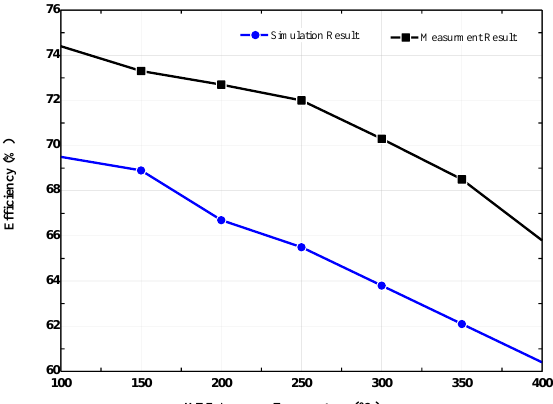
Figure 5. Effect of HTF average temperature on collector efficiency in compaction with measured data of Dudley et al.